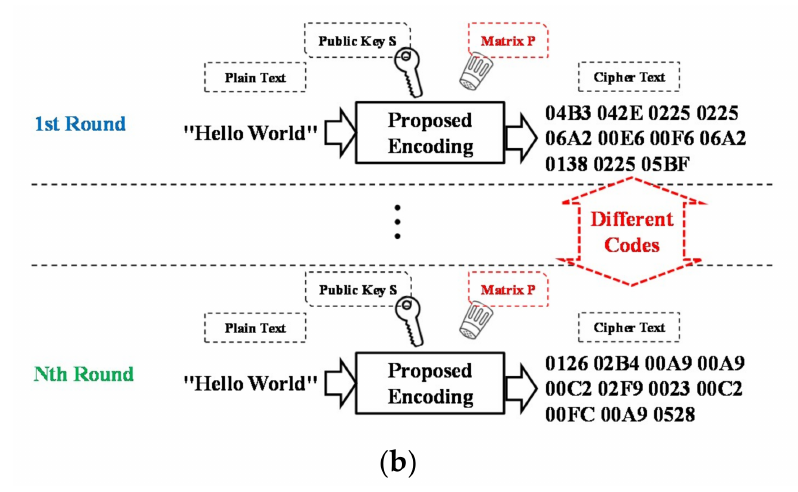
Figure 4. Encoding processes of ( a ) RSA and ( b ) proposed